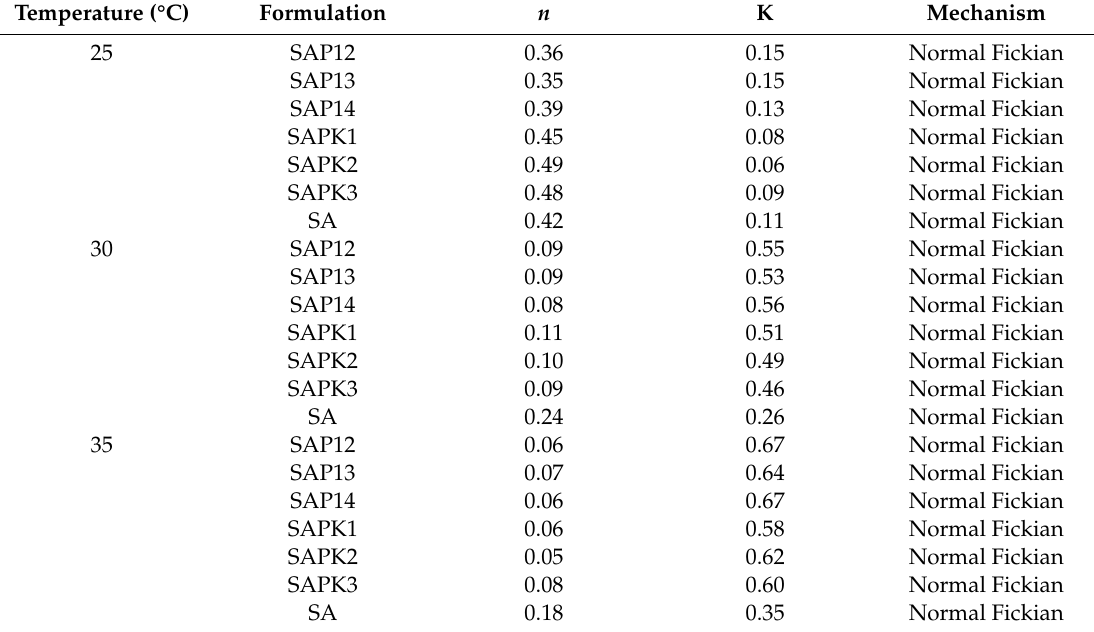
Table 4. Di ff usion exponent, kinetic constant, and mechanism for the release of spores. Temperature